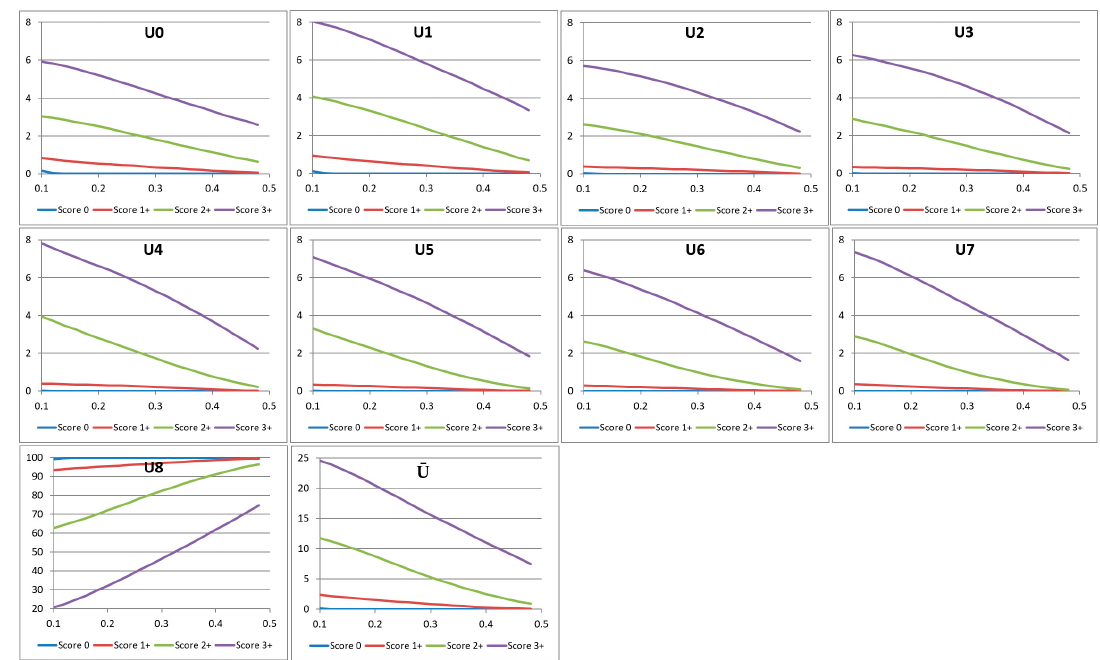
Figure 7. The values of the first four uniform local binary pattern (uLBP) bins corresponding to four images with different HER2 scores. The x -axis denotes the variation of the saturation threshold s low from 0.1 to 0.5.